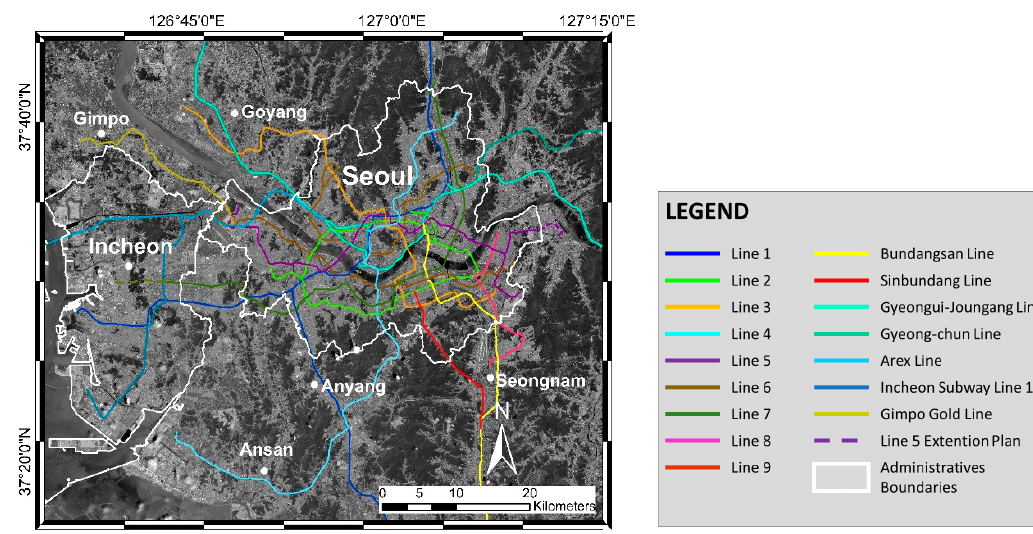
Figure 1. Optical image of Seoul (gray) captured by Sentinel-2 on 19 June 2019 with subway lines superimposed.